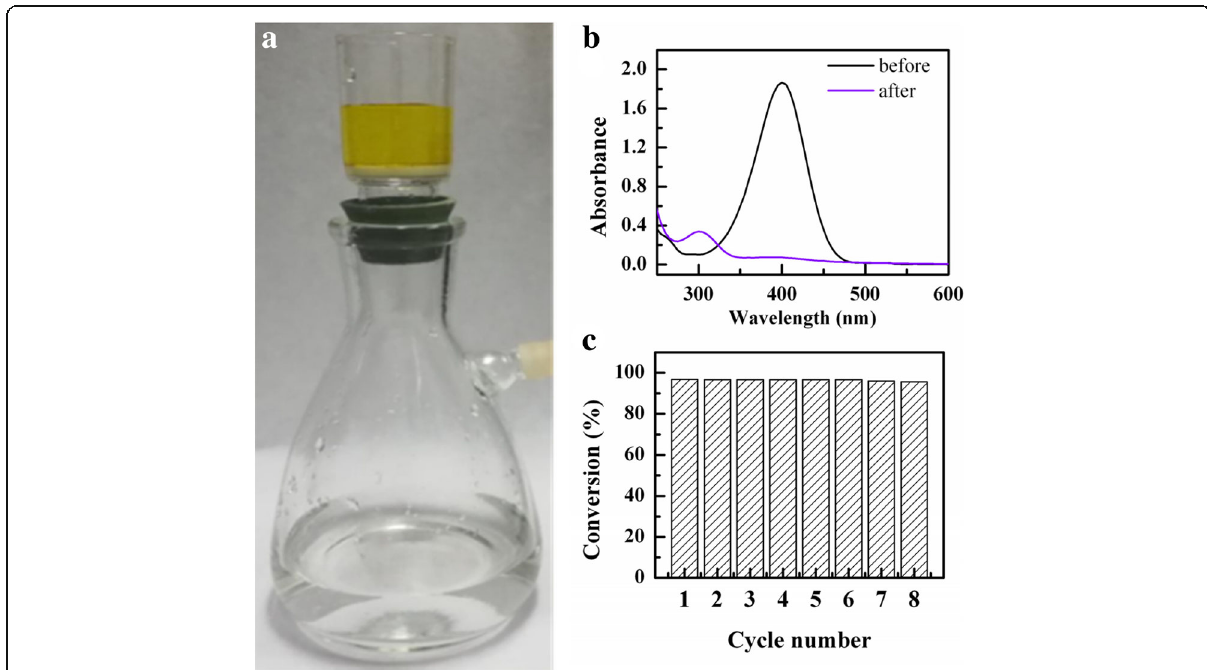
Fig. 11 a Photograph showing the fast reduction of 4-NP passing through an nAg@PSA catalytic membrane. b UV-vis spectra of 0.12 mM 4-NP with 36 mM NaBH 4 before and after passing through the nAg@PSA catalytic membrane. c The conversion rate of 4-NP during the cyclic